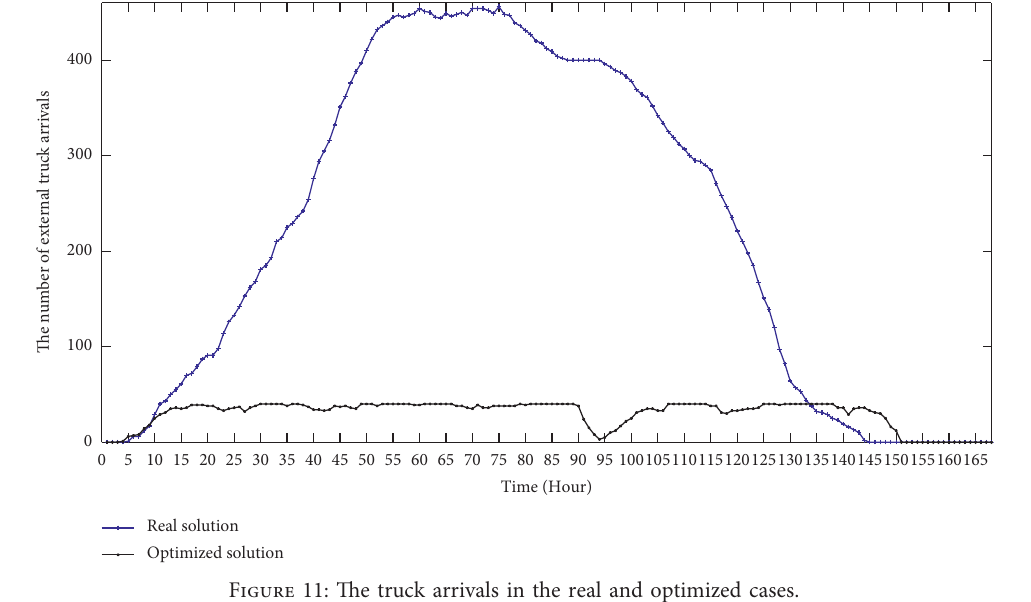
Figure 11: The truck arrivals in the real and optimized